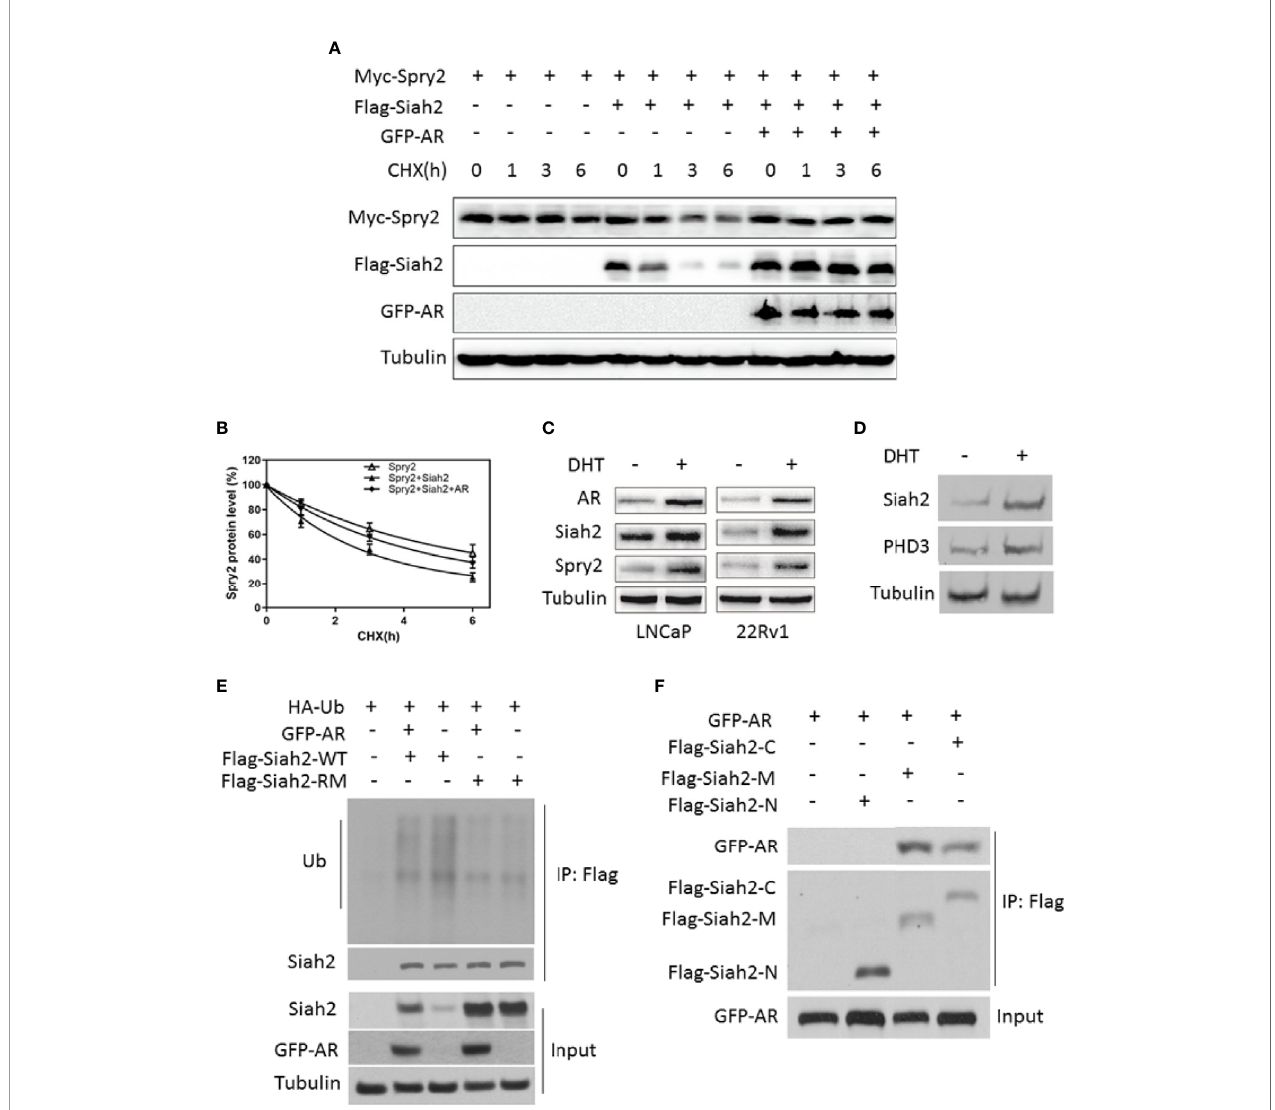
FIGURE 2 | AR inhibited Siah2 auto-ubiquitination and decreased its E3 ligase activity. (A) HEK293 cells were transfected with Flag-Siah2, GFP-AR, and Myc-Spry2 as indicated for 48 h, and then treated with cycloheximide (CHX, 50 m g/ml) for 1, 3, and 6 h. Cell lysates were then subjected to Western blotting. (B) Degradation curves of Spry2 by cycloheximide chase experiments in the presence or absence of Siah2 or AR. (C) LNCaP and 22Rv1 cells were cultured in CS-FBS medium for 24 h, and subsequently treated with 10 nM DHT or vehicle for 24 h. Spry2, Siah2, and AR protein expression were detected by Western blotting. (D) LNCaP cells were cultured in CS for 24 h, subsequently treated with 10 nM DHT or vehicle for 24 h. Siah2and PHD3 protein expression were detected by Western blotting. (E) PC3 cells were transfected with Flag-Siah2-WT or Flag-Siah2-RM, GFP-AR and HA-Ub as indicated for 24 h, and treated with 5 m M MG132 for 16 h. Cell lysates were immunoprecipitated with Flag antibody and subjected to Western blotting with HA and Flag antibody. (F) GFP-AR was co-transfected with Flag-Siah2 fragments (N, N-terminal region; M-middle region; C, C-terminal region) into HEK293 cells. Cell lysates were immunoprecipitated with Flag antibody and subjected to Western blotting with Flag and GFP